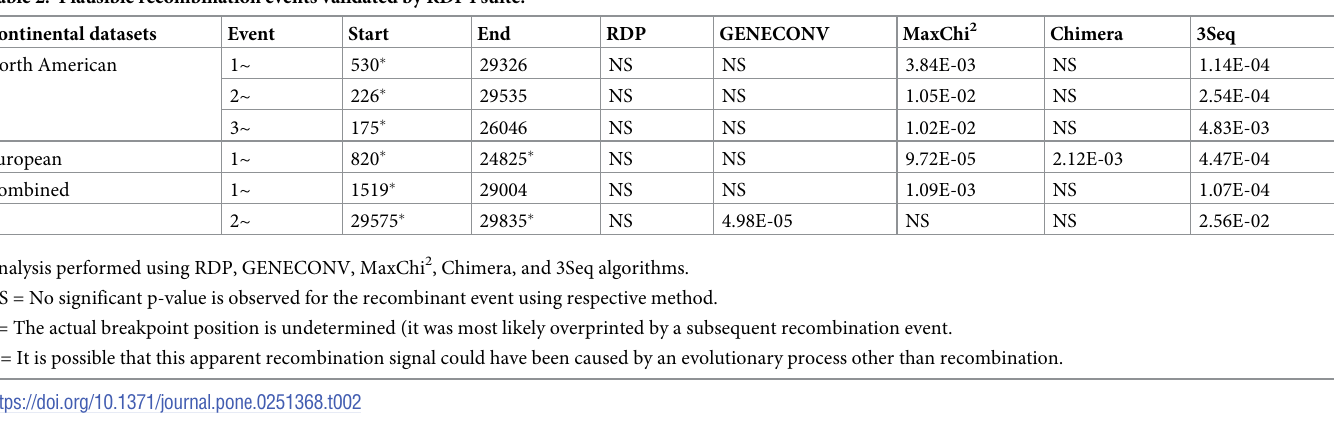
between variants directly from individual continental datasets having large sample size. Sur- prisingly, we observed different sets of variants in haplotype blocks, different lengths of haplo- type blocks, and differences in nonsynonymous composition in haplotype blocks among the three continents datasets ( Fig 4 ). Table 4 describes characteristics of the haplotype blocks observed in the datasets from Asia, Europe, and North America. Correlation between LD and physical distance suggested that a strong LD was observed in North American sequences throughout the genome compared to sequences from other continents ( Fig 5 ). The South American and European sequences showed strong LD towards the upstream region of ORF1a gene, while North American and Oceanic sequences showed strong LD from the S protein region to the end of the genome. Table 3. MAF distribution of 18 variants involved in haplotype block of combined dataset in each continental data. SNV Minor allele